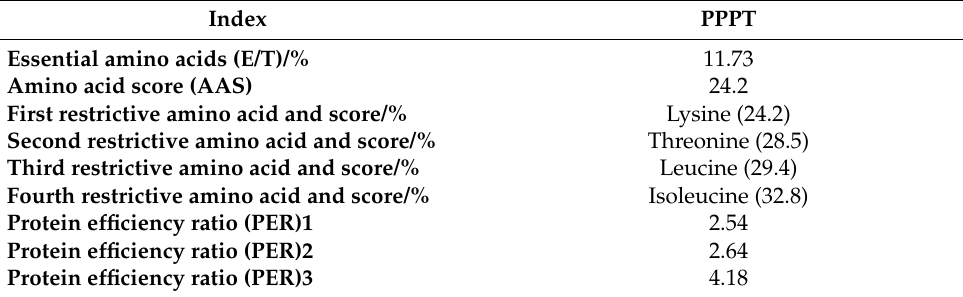
Table 3. Nutritional evaluation of